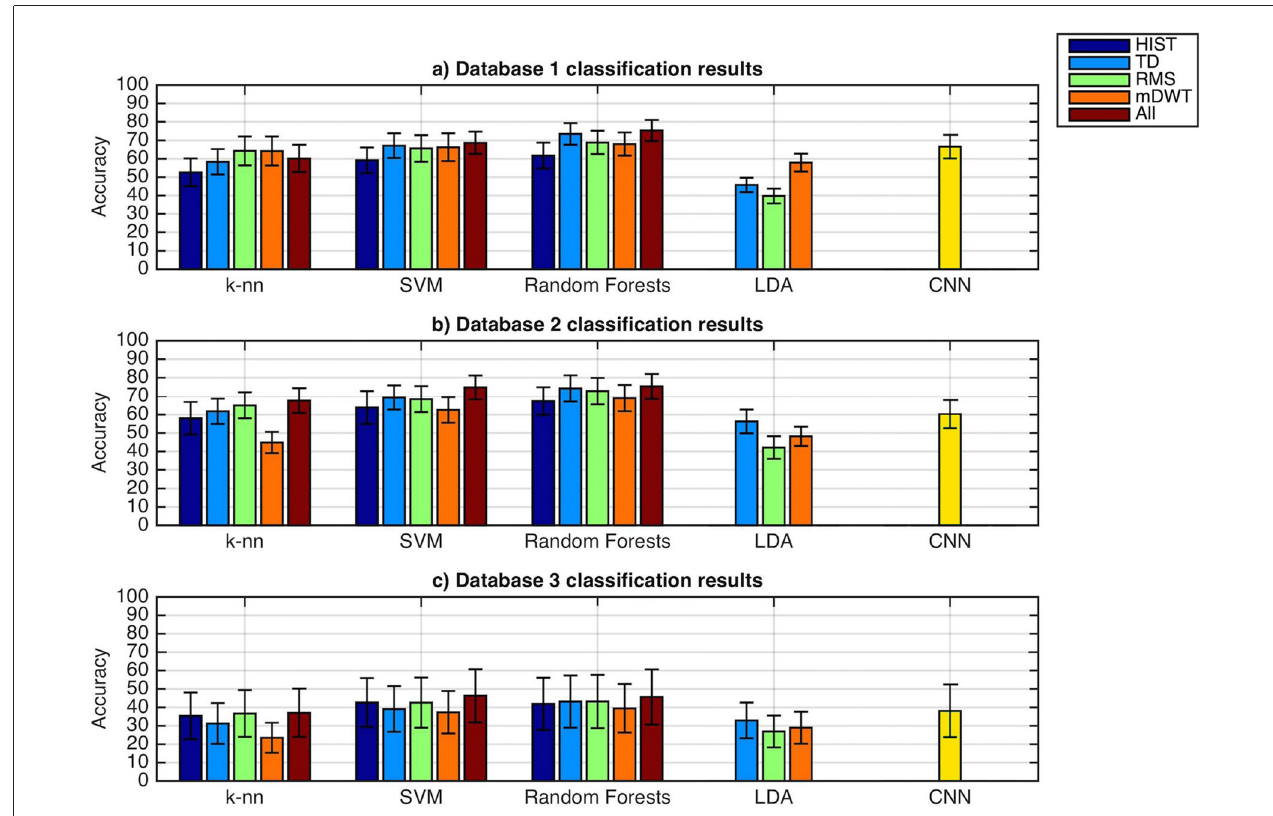
FIGURE 2 | Classification accuracy obtained with the classical classification techniques and the presented convolutional neural network. The datasets include sEMG data with an average of more than 50 hand